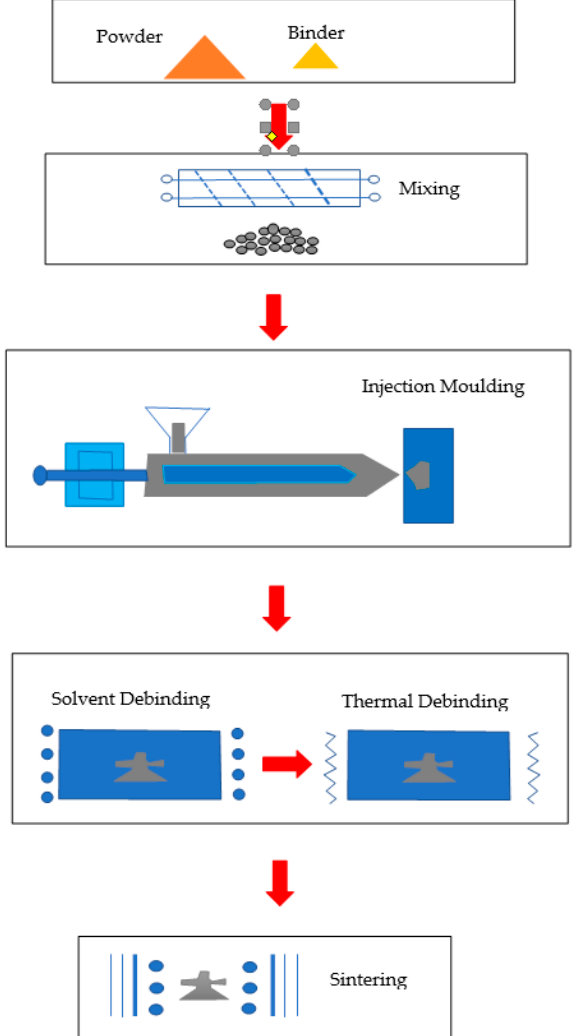
Figure 4. Overview of Powder Injection Moulding Process [121].